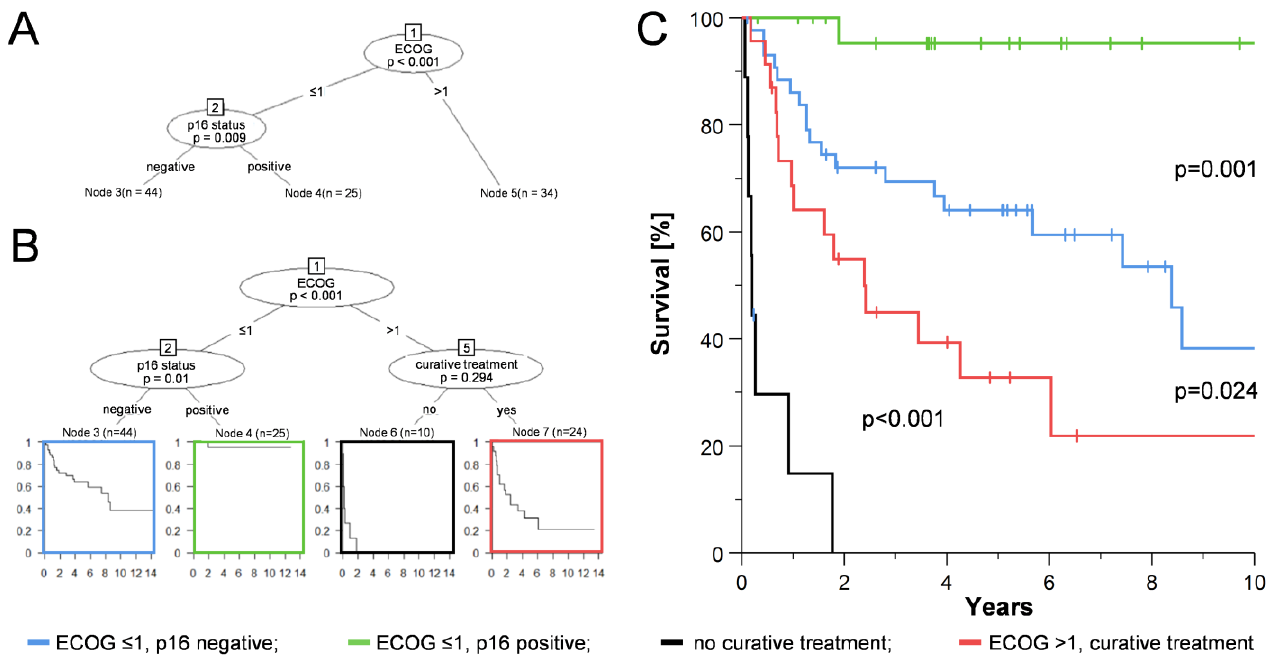
Figure 2. Development of a risk model for CUP HNSCC . ( A ): Multivariate analysis of patient character- istics and risk factors by recursive partitioning (RPA). Included factors: p16 status (negative/positive), HR-HPV DNA detection (negative/positive), gender (female/male), age (years), N stage (1–3), extranodal extension (no/yes), tobacco (no/yes) and alcohol (no/yes) consumption, performance status (ECOG 0–4), and histological grading (low: ≤2/high: >2). The splitting threshold was set to 0.05, and the p -values calculation was set to “Bonferroni”. Only splitting at nodes 1 (ECOG) and 2 (p16) resulted in significant differences in the OS of subgroups. ( B ): As figure A only with the addition of curative treatment possibility (no/yes) in the RPA and splitting threshold set to 0.5 to allow for node formation without significant difference in OS of the resulting groups. ( C ): OS of patients with CUP HNSCC stratified by the RPA model generated in ( B ). p : p -value (log-rank test).